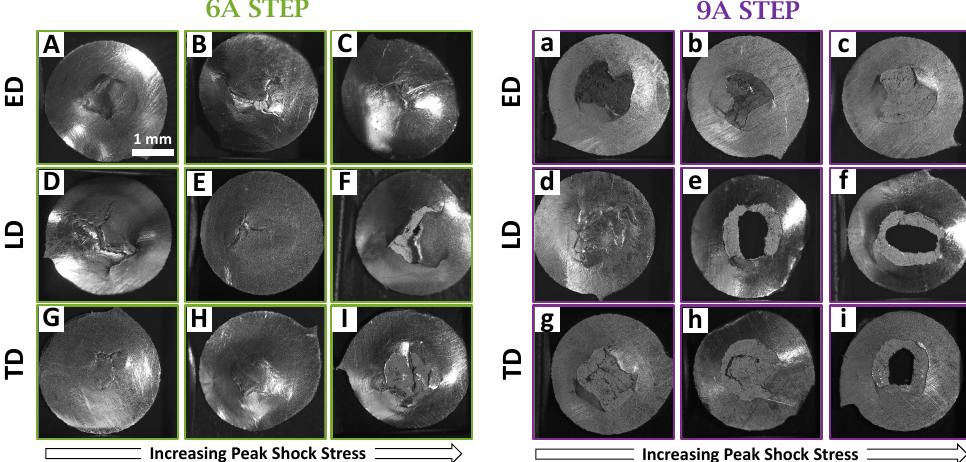
Figure A4. Macroscopic optical post-mortem images for STEP sample sets. Each 3 × 3 grid of images shows characteristic macroscopic damage morphologies for ( A – I ) 6A STEP and ( a – i ) 9A STEP. Each row shows the results for a specific impact orientation: ( top ) ED, ( middle ) LD, and ( bottom ) TD. The peak shock stress within each column is nominally identical and increases from left to right from low to mid to high based on the range shown in Figure